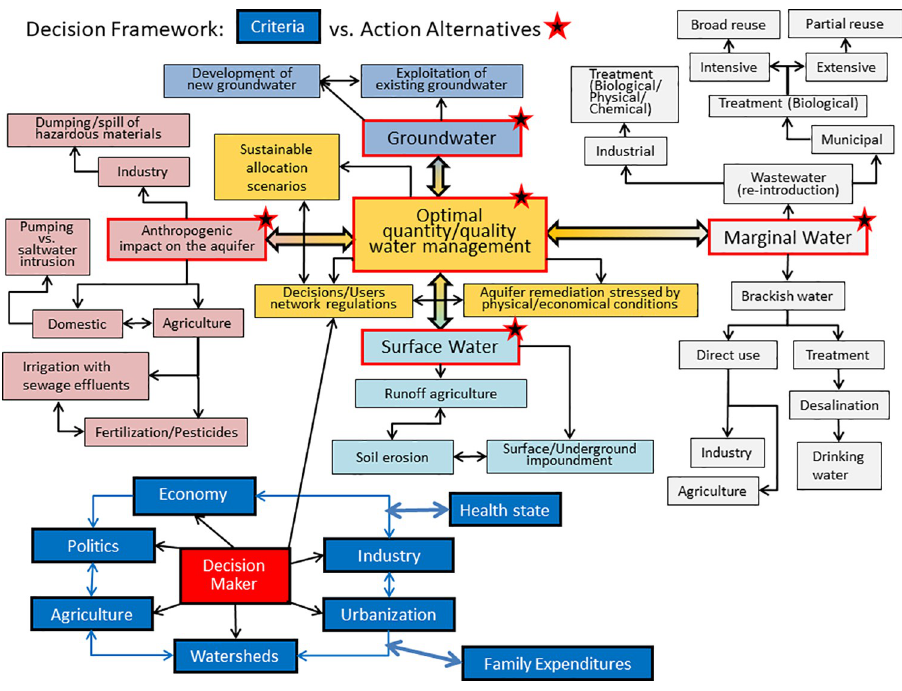
Fig 2. Possible core, water related, action alternatives interlinked with criteria (i.e., decision framework) and associated with the WFE nexus. Alternatives (emphasized by different colors) are associated with sub-units.